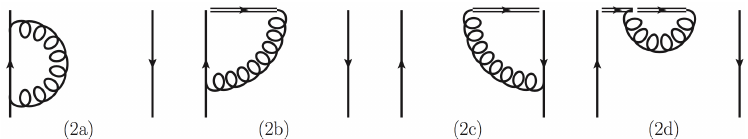
Figure 2: Virtual diagrams in the QTM at one-loop order. The Hermitian conjugate diagrams for (2a) and (2d) have not been